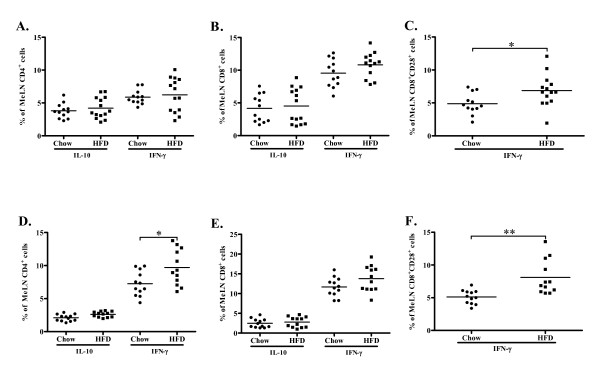
Expression of IFN-γ and IL-10 in CD4+ and CD8+ cells in mediastinal lymph nodes (MeLN). Fig. A-C depicts MeLN cells at 4 weeks and fig. D-F depicts MeLN cells at 8 weeks. There was no difference in IL-10 or IFN-γ production in (A) CD4+ or (B) CD8+ cells between mice fed a high fat diet (HFD) and a chow diet. (C) HFD-fed mice expressed a higher fraction of IFN-γ producing CD8+CD28+ cells compared to mice fed chow diet. (D) Increased IFN-γ production of CD4+ cells of high fat diet (HFD) fed mice compared to CD4+ cells from mice fed a chow diet. (E) No difference in the relative size of CD8+IFN-γ+ and CD8+IL-10+ cells between mice fed HFD and chow diet. (F) Increased IFN-γ production in CD8+CD28+ cells in HFD-fed mice compared to mice fed chow diet. *P < 0.05, **P < 0.01.